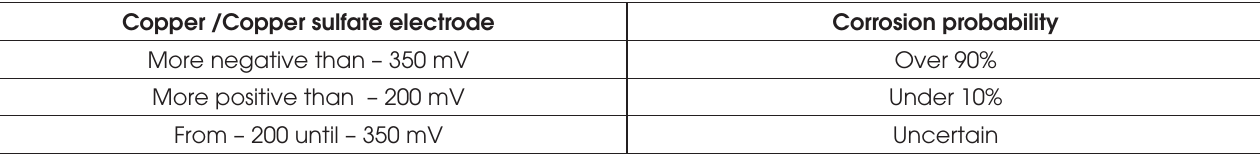
Ranges of corrosion potential and their correlation with corrosion probability according to ASTM C 876: 2009 [18] Copper /Copper sulfate